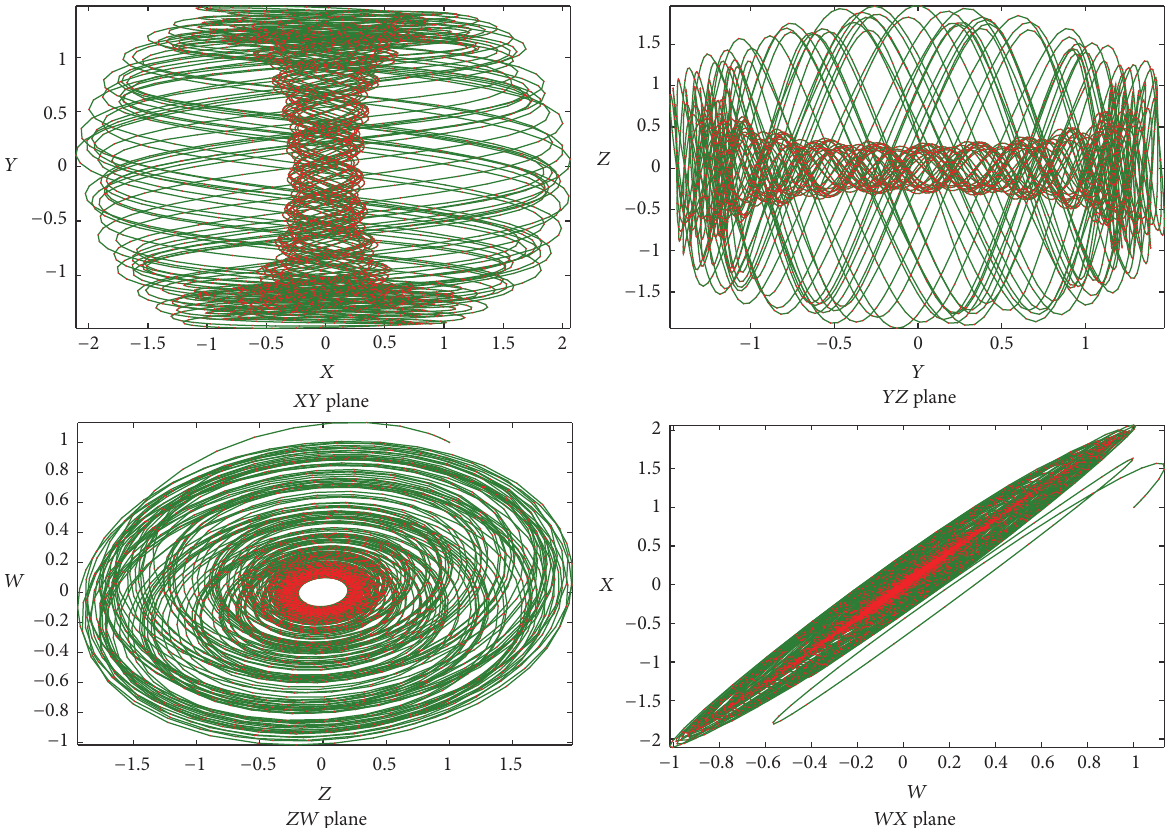
Figure 21: 2D state portraits of the FOMENS system implemented using Xilinx system generator ( 𝑋𝑌𝑍 plane; 𝑌𝑍𝑊